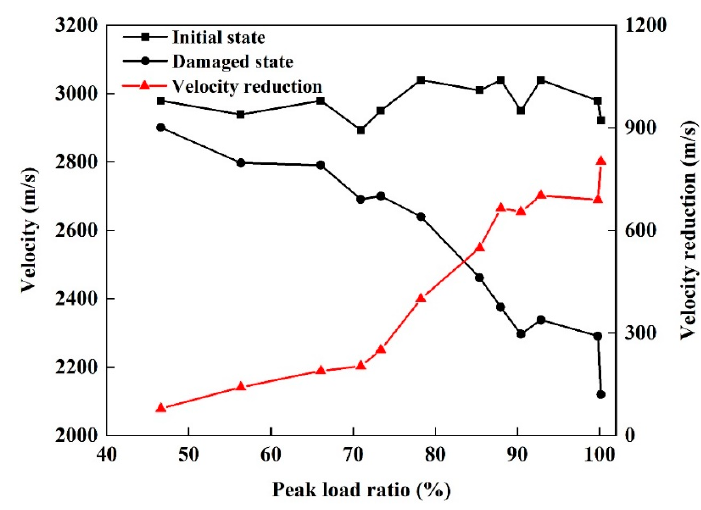
Figure 8. Wave velocities for sandstone specimens before and after damage.